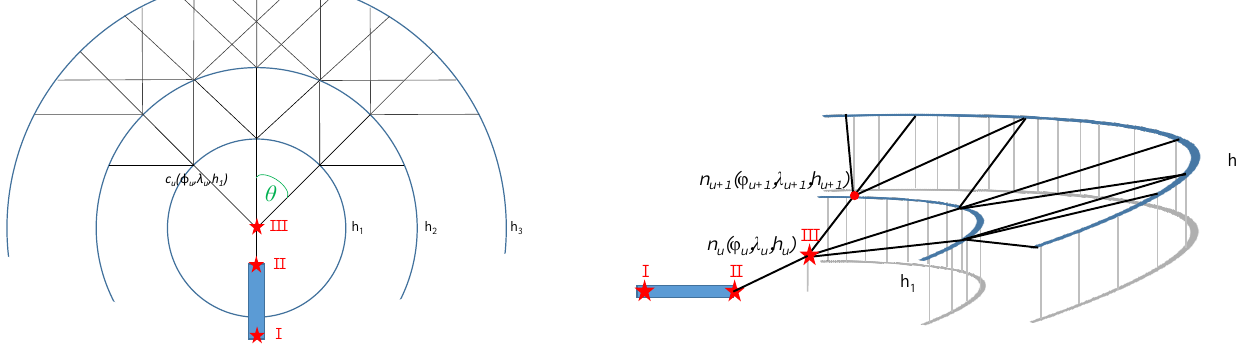
Figure 3. Top view (left) and 3D view (right) of a simplified 3D path search grid for the climb with θ = 45 ◦ and three different optimization altitudes A = { h 1 , h 2 , h 3 } . The grid expands at the extended runway centerline of node III , which is also the current node n , resulting in a projected neighbor node n u